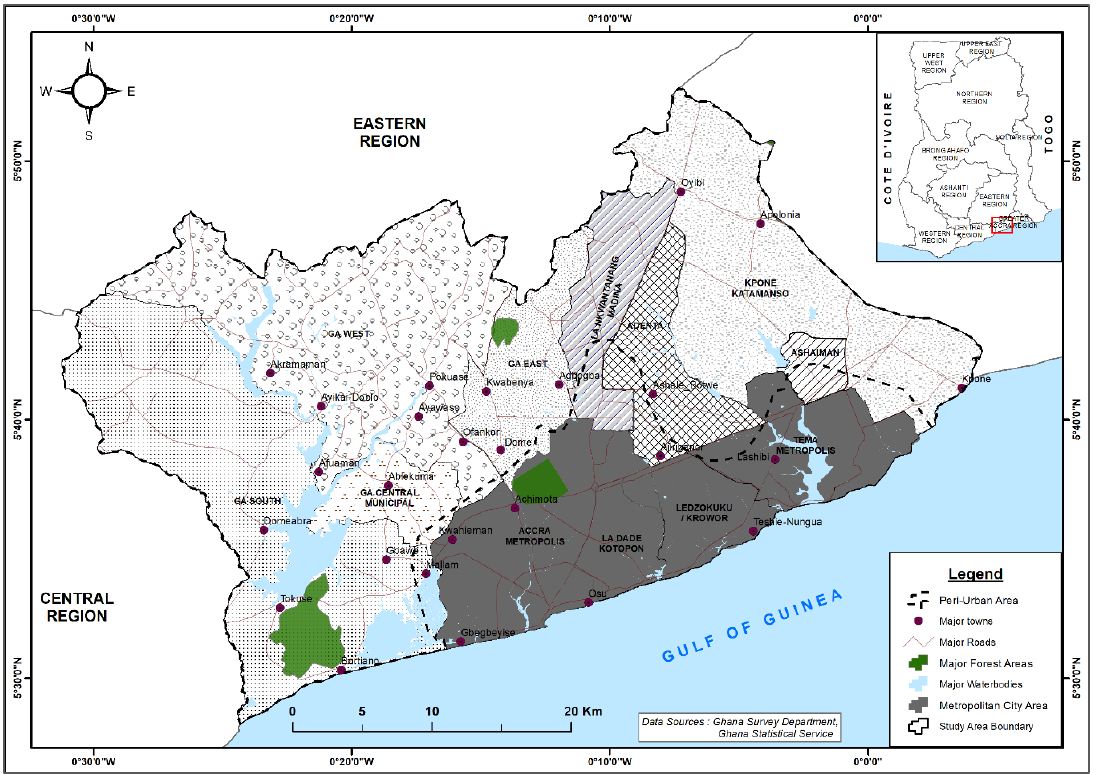
Figure 1. Location map of the study area.